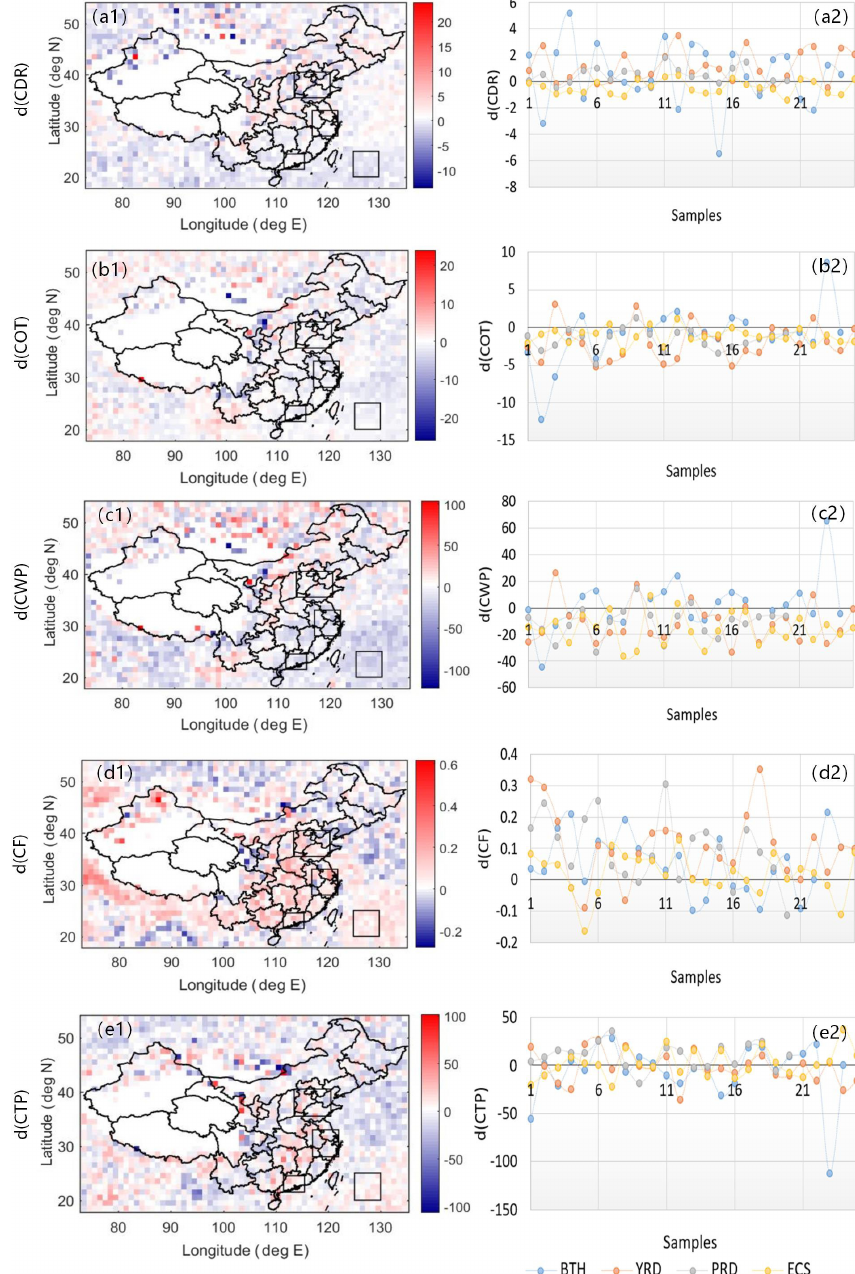
Figure 7. Spatial distributions (left, a1–e1 ) and sample time series (right, a2–e2 ) of d(Cloud_ X ) (as defined in Sect. 3.2) for CDR, COT, CWP, CF and CTP over eastern China during the time period